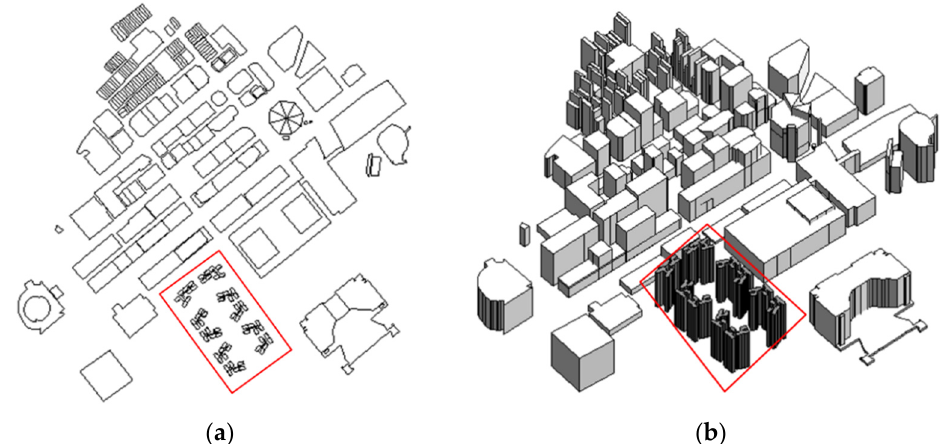
Figure 13. Design scenarios based on modular buildings. ( a ) Plan view, ( b ) 3D view.